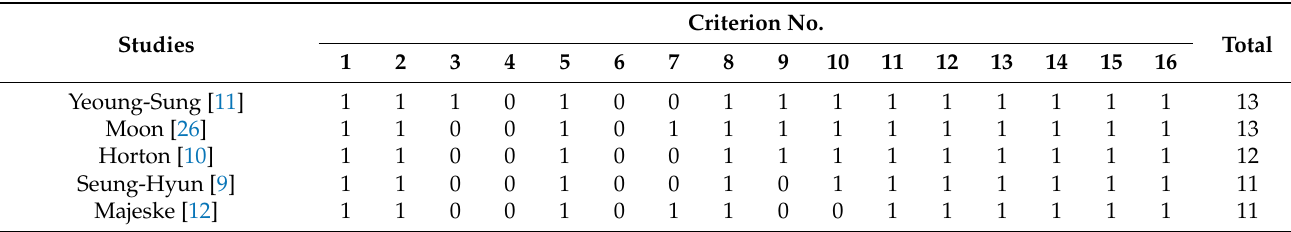
Table 2. Methodological quality of the five studies using the modified McMaster Critical Review Form for Quantitative Studies ( ≥ 9/16).